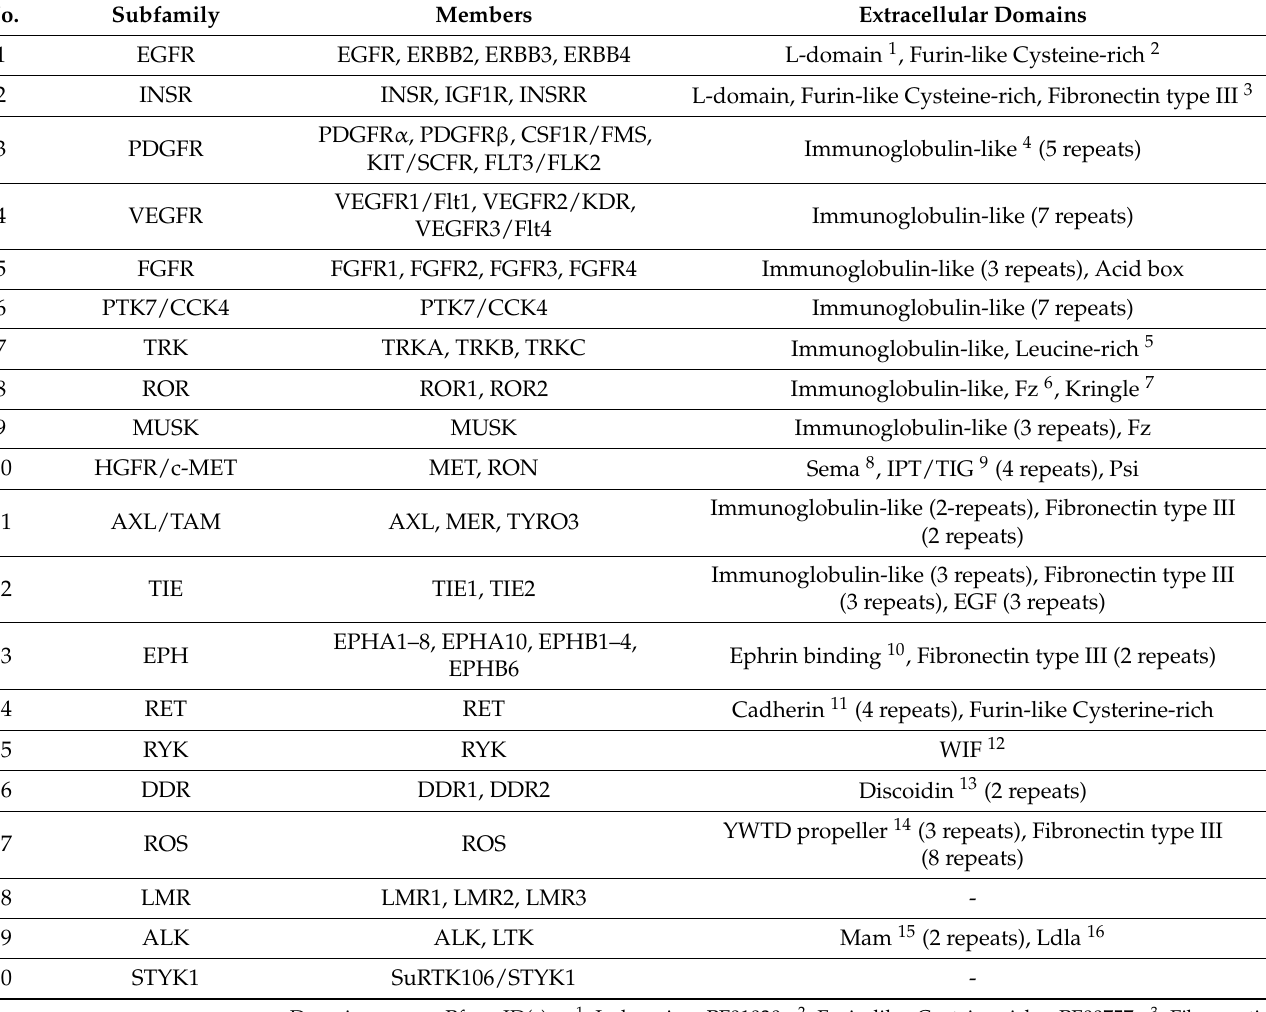
Table 1. The 20 subfamilies of the 58 human RTKs. The table contains the name(s) of each subfam- ily, the members of each subfamily and the main extracellular domains found in the members of each